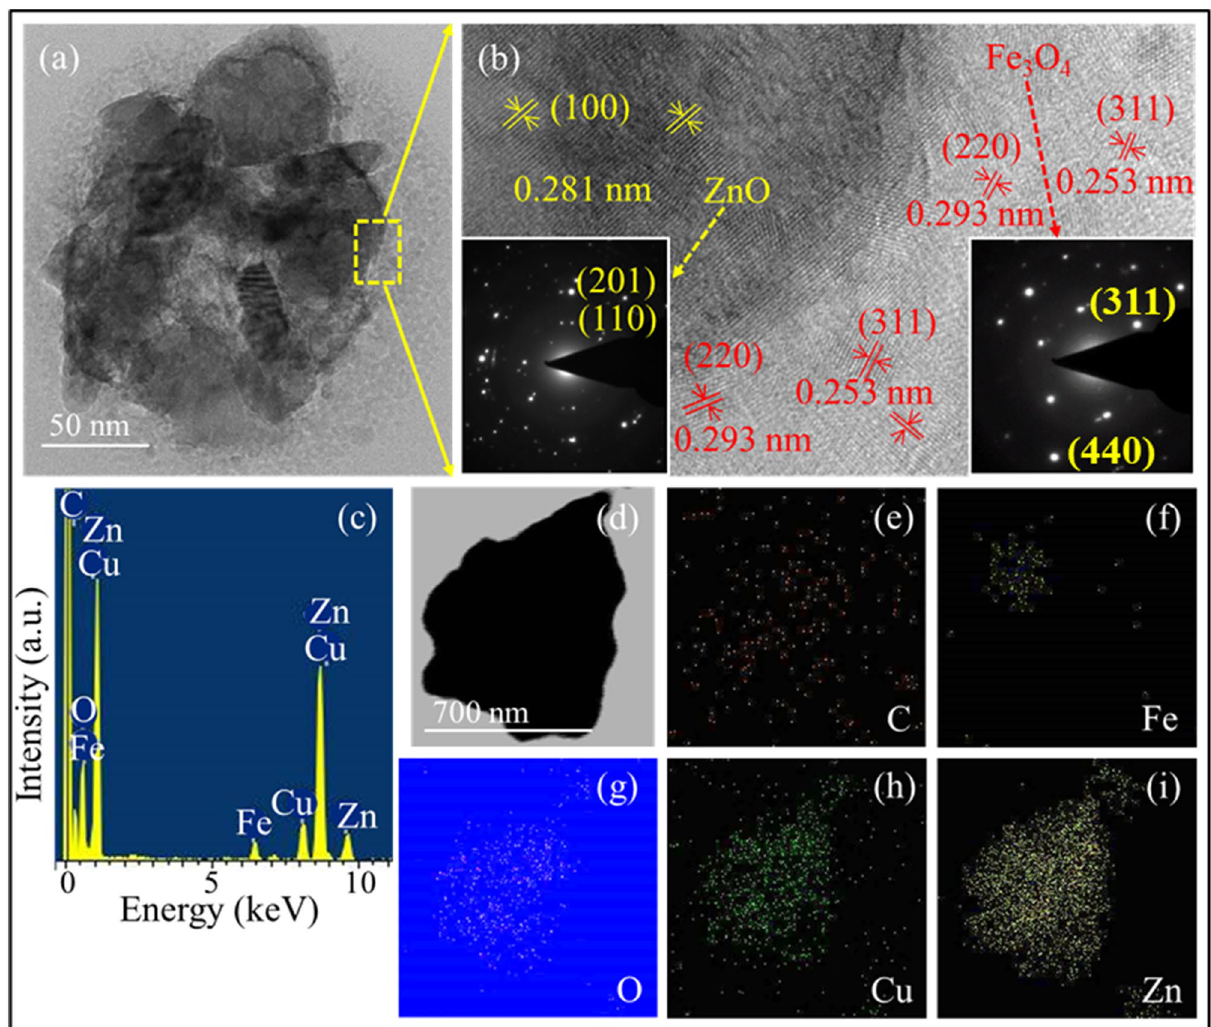
Figure 4. Electron micrographs and elemental mapping of sample FZB ( a ) bright-field image, ( b ) HRTEM micrograph, ( c ) EDS analysis, ( d ) area selected for elemental mapping ( e – i ) elemental mapping of individual elements ( e ) C, ( f ) Fe, ( g ) O, ( h ) Cu, and ( i ) Zn (the images were obtained using TEMCON